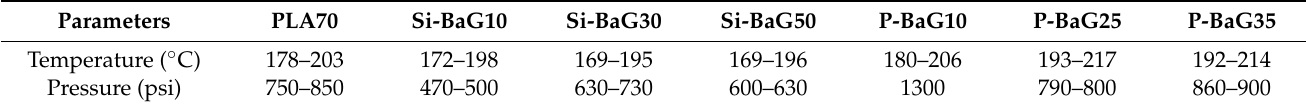
Table 2. The processing conditions of the PLA70 and the